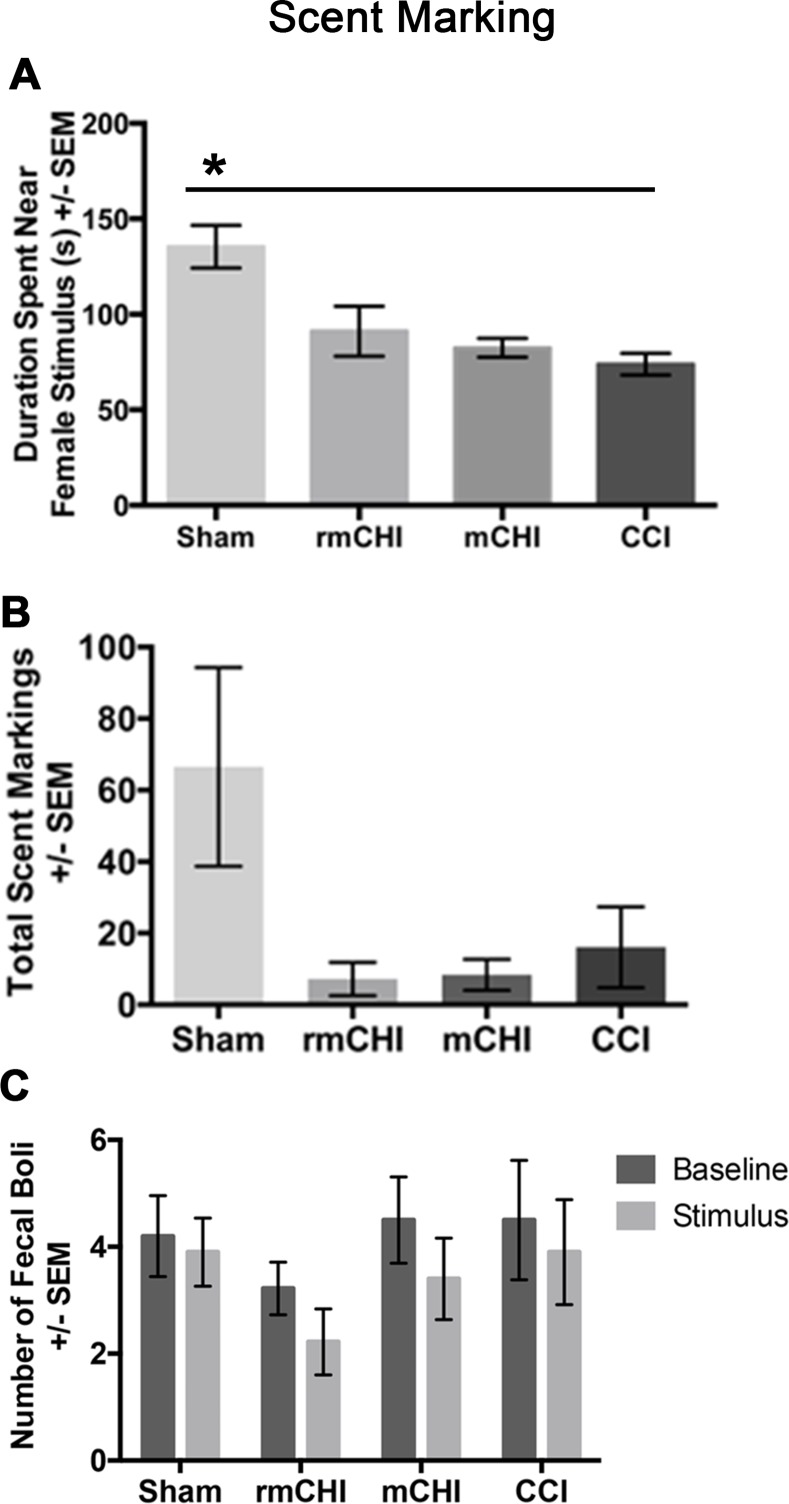
TBI leads to social inhibition.(A) All injured mice spent less time exploring near the female stimulus mice (*p<0.05). (B) rmCHI mice appeared to produce the least scent markings across injury groups, but results were not statistically significant. (C) There were no significant differences in the number of fecal boli produced by each animal across injury groups between stimulus and baseline testing.